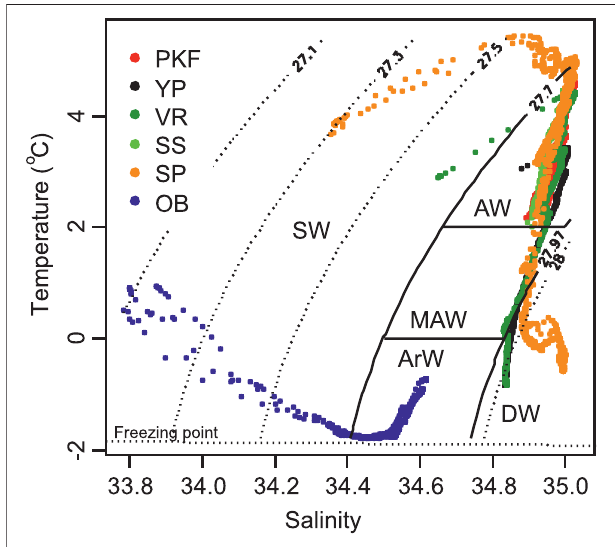
FIGURE 2 | Water mass de fi nitions on temperature vs. salinity diagram fromtheCTDpro fi les.27.70 – 27.97 kg/m 3 σ t isoclinesseparateSurfacewater (SW) and Deep Water (DW) and 0 – 2 ° C horizontal temperature lines separate Atlantic Water (AW) and Arctic Water (ArW) from Modi fi ed Atlantic Water (MAW). Colored data points indicate the sample data for each region listed in Table 1